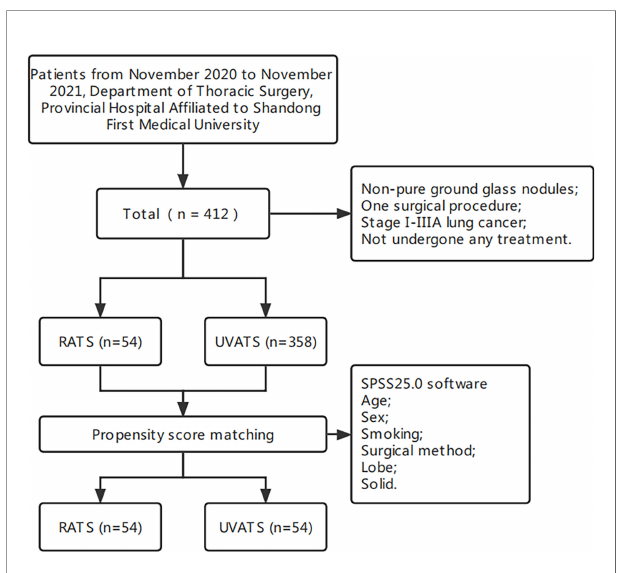
FIGURE 1 | Flow-chart of the